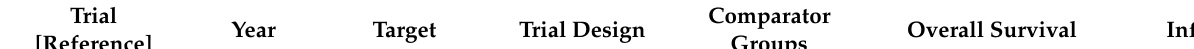
Table 1. Non-chemotherapy targeted drug clinical trials that progressed to approval.